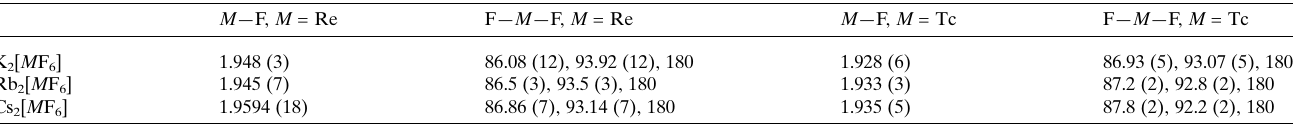
Table 1 Structural details (A˚ , (cid:5) ) of the [ReF 6 ] 2 (cid:2) anion in this study and of the related anion in [TcF 6 ] 2 (cid:2) salts a . M —F, M = Re F— M —F, M = Re